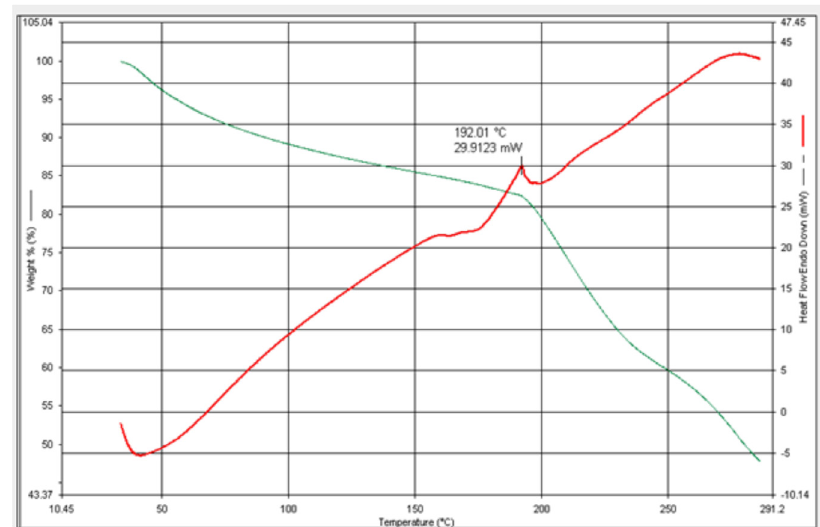
FIGURE 8 (e) - Differential scanning calorimetric analysis of formulation F2.